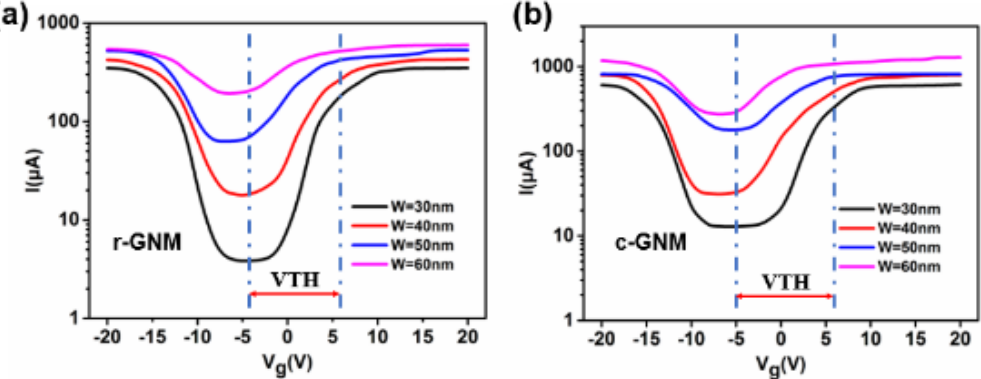
Figure 13. GNM transfer characteristic curves with dimensions of 30, 40, 50 and 60 nm, respectively. ( a ) r-GNM ( b ) c- GNM.